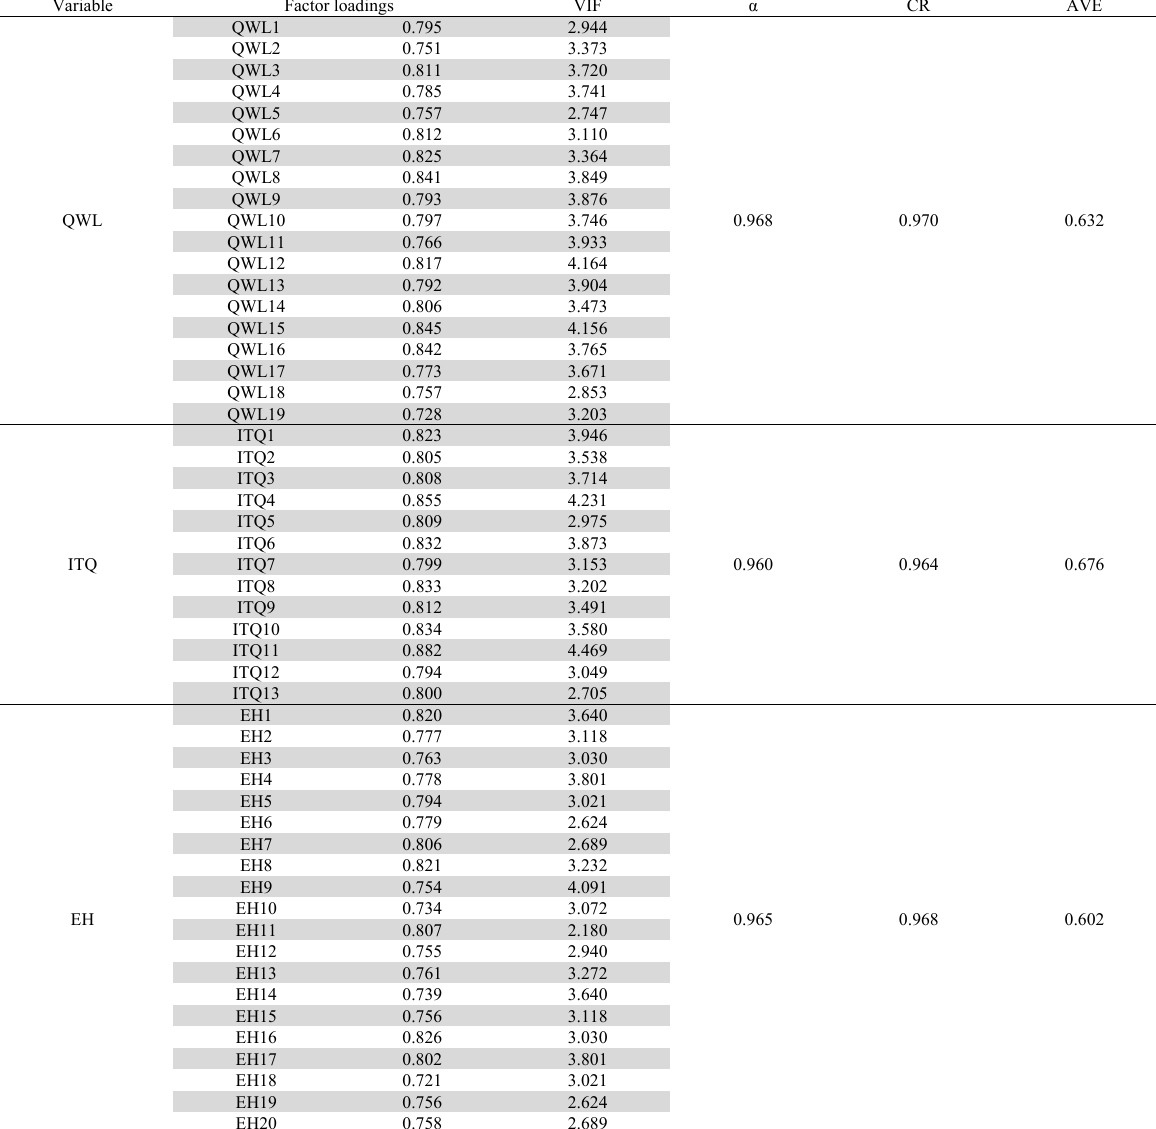
Factor loadings, reliability and reliability